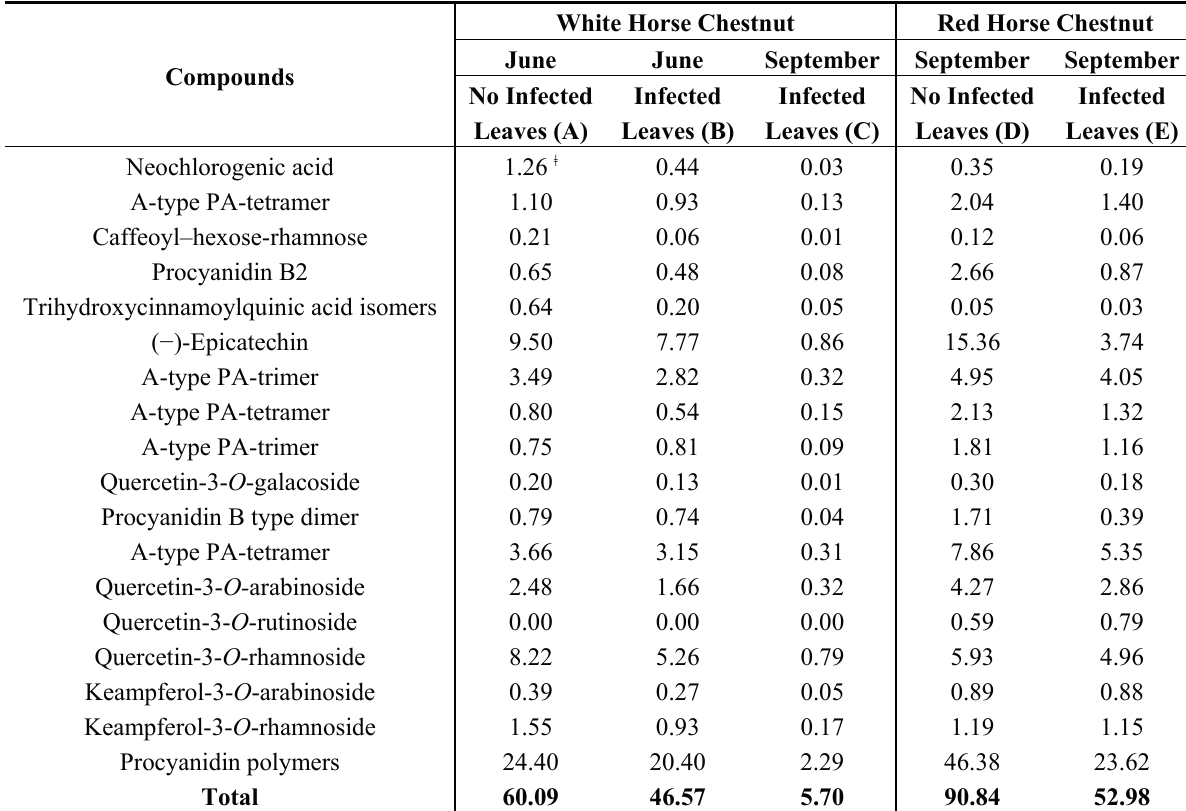
Table 2. The content [mg/g dm] of phenolic compounds of the extracts of white and red chestnut horse leaves before and after infection